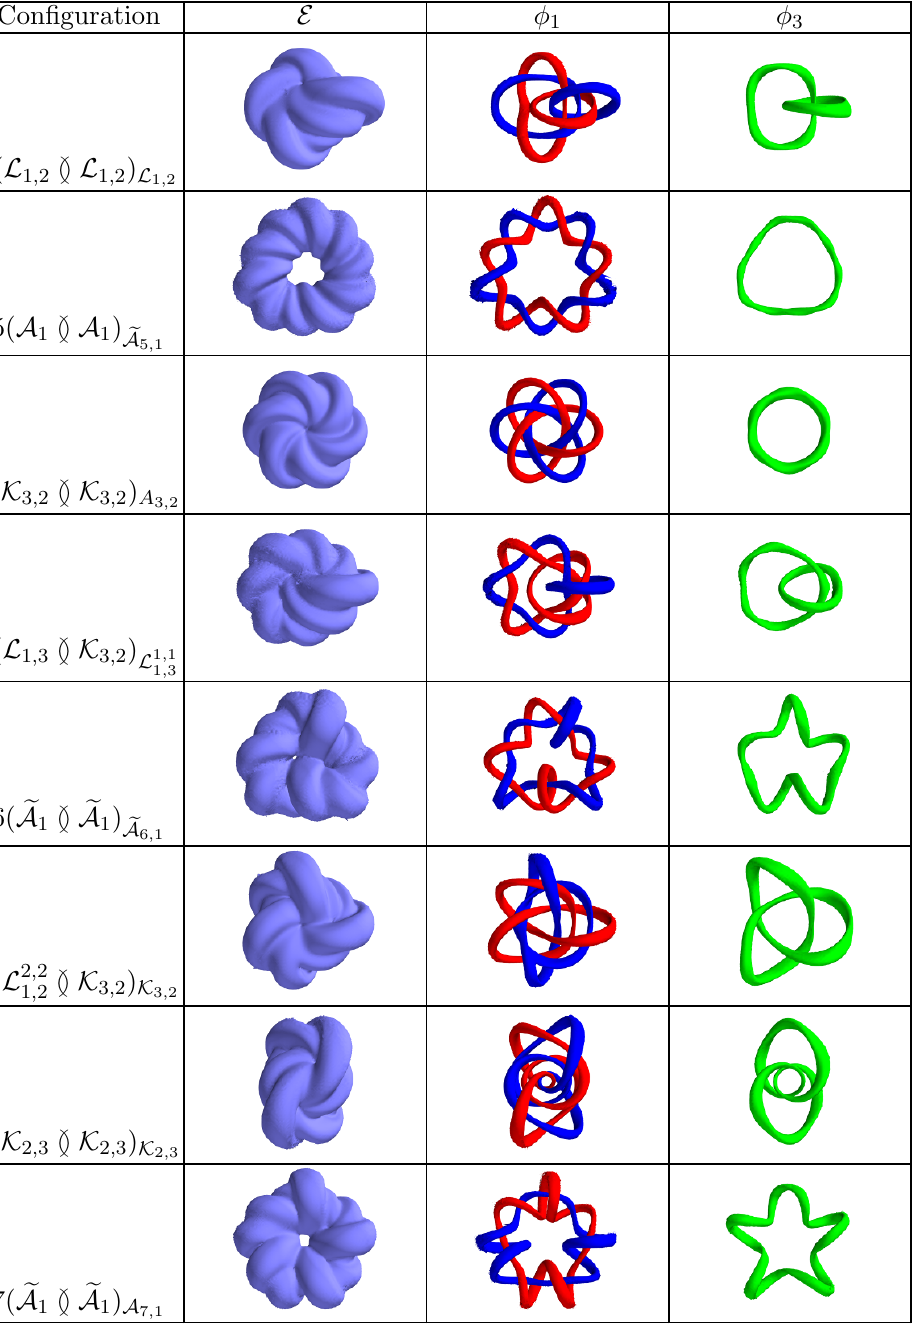
Table 1 . E = 15 isosurface and the isosurfaces of the (cid:12)eld components (cid:30) 1 = (cid:6) 0 : 9 and (cid:30) 3 = (cid:0) 0 : 9 for Q = 1 (cid:0) 7 Hop(cid:12)ons in the model (2.1) with c 2 = 0 : 5 ; c 4 = 1 ; m = 4 and potential V = m 2 (cid:30) 2